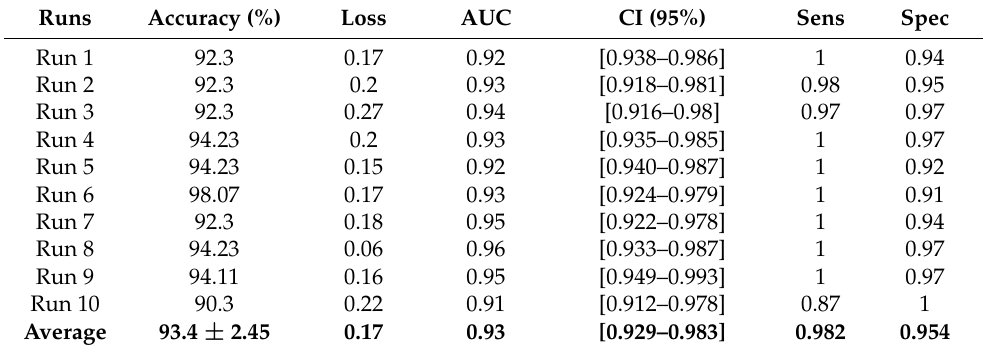
Table 4. Runs of 10-fold cross-validation of the proposed RGB-CNN architecture.